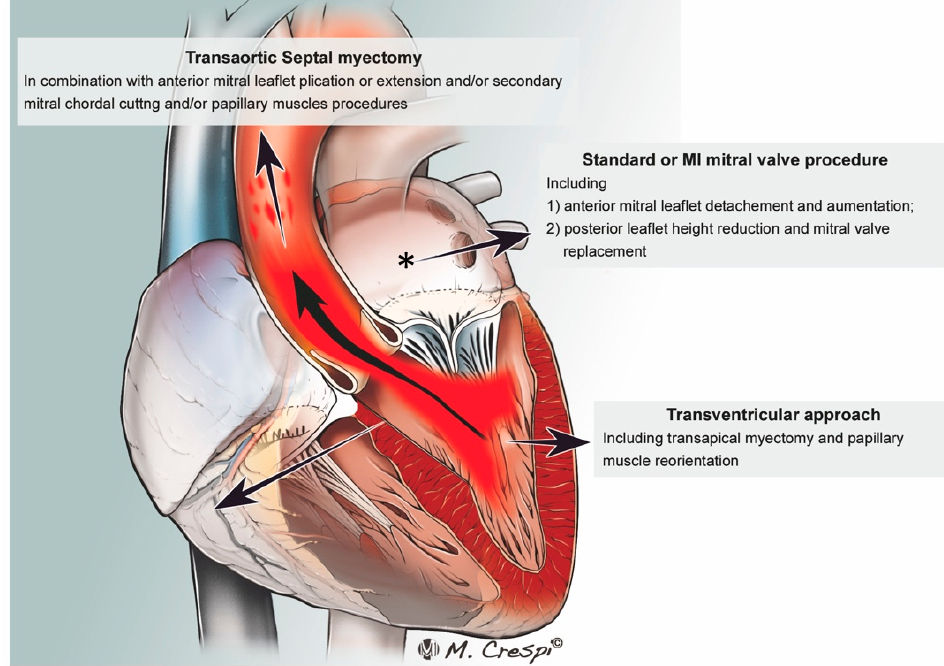
Figure 1. Summary of the proposed techniques for LVOT obstruction surgery. LA, left atrium. *—Conventional and minimally invasive mitral valve surgery approaches.